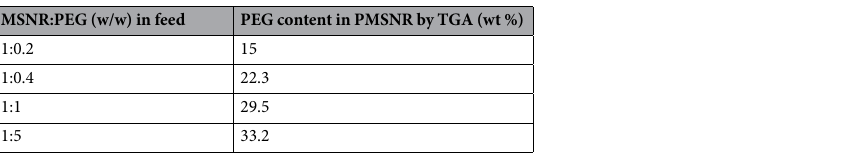
Table 1. PEGylation of